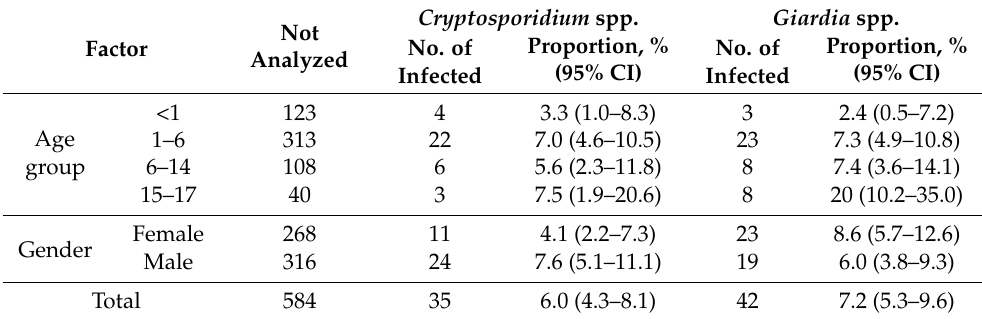
Table 1. Number of analyzed, infected, and proportion with 95% confidence interval (95%CI) of children with Cryptosporidium spp. and Giardia spp. in different age and sex groups. Cryptosporidium spp. Giardia spp. Not Proportion, % Proportion, % No. of No. of Factor Analyzed (95% CI) (95% Infected Infected